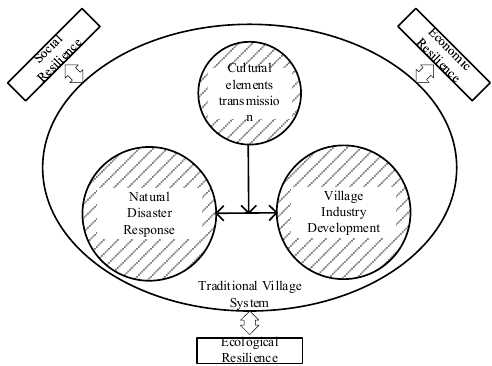
Figure 9. Z&C mode diagram.